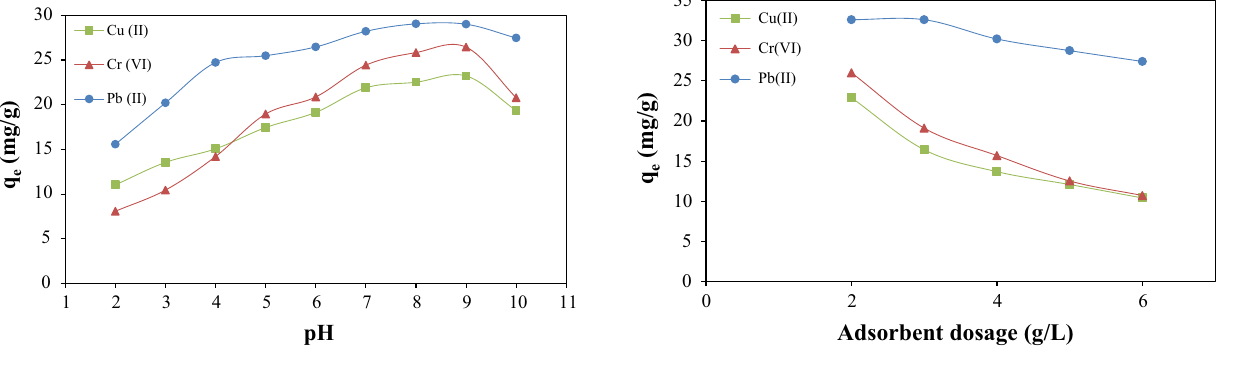
Fig. 8 Effect of adsorbent dosage on uptake amounts of Cu (II), Cr(VI) and